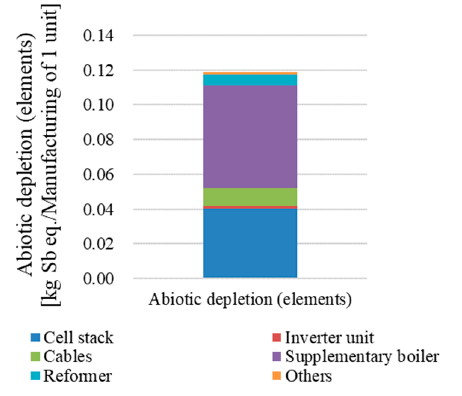
Energies 2023 , 16 , 1985 Figure 11. Results of ADP (elements) during the manufacturing stage. Figure 11. Results of ADP (elements) during the manufacturing stage .